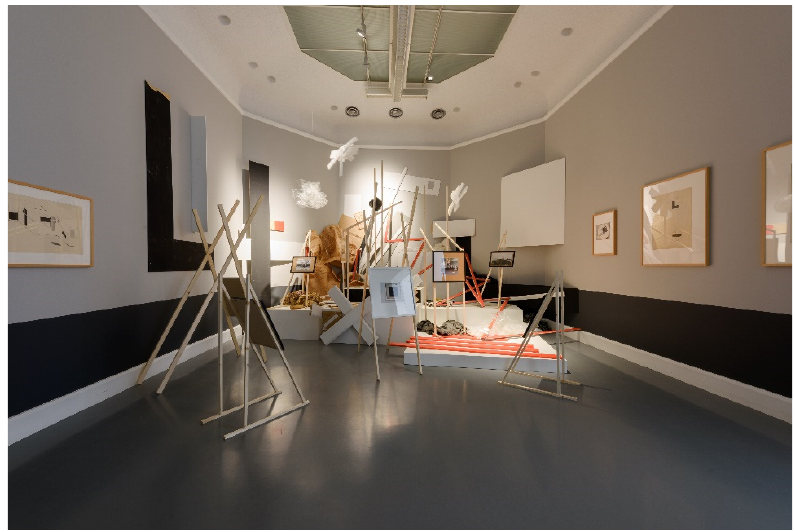
Figure 33. View of one of the rooms in the exhibition ‘Positions #2’, Van Abbemuseum, 2015. Sarah Pierce, ‘Gag’, 2015. Photo: Peter Cox. Sarah Pierce, ‘Gag’, 2015. Photo: Peter